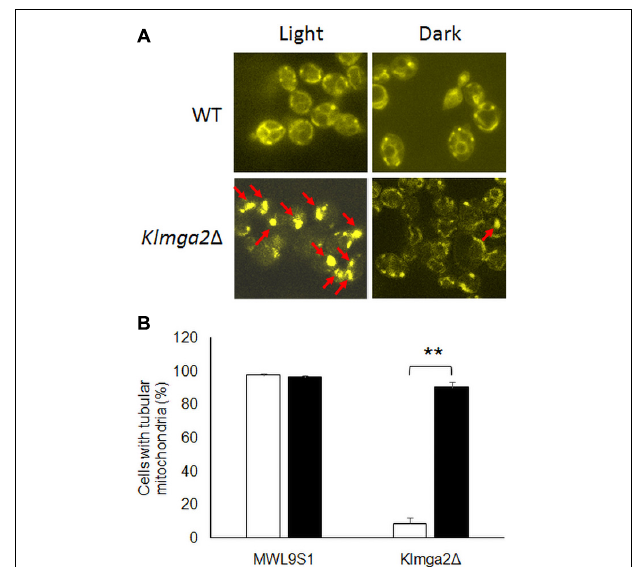
FIGURE 3 | Fluorescence microscopy analysis of wild type and mutant strains Klmga2 (cid:49) . (A) Reports DASPMI staining of the mitochondrial network of wild type MWL9S1 and Klmga2 (cid:49) strains. The red arrows show the non-tubular collapsed mitochondrial network. (B) Shows histogram reporting the percentages of tubular mitochondria-containing cells. White and black blocks refer to light and darkness cultivation, respectively. Growth medium was YPD. Two or three independent cultures were performed for each strain/condition, and 100–700 cells were analyzed. Standard deviations (SD) are reported. ** indicates p <